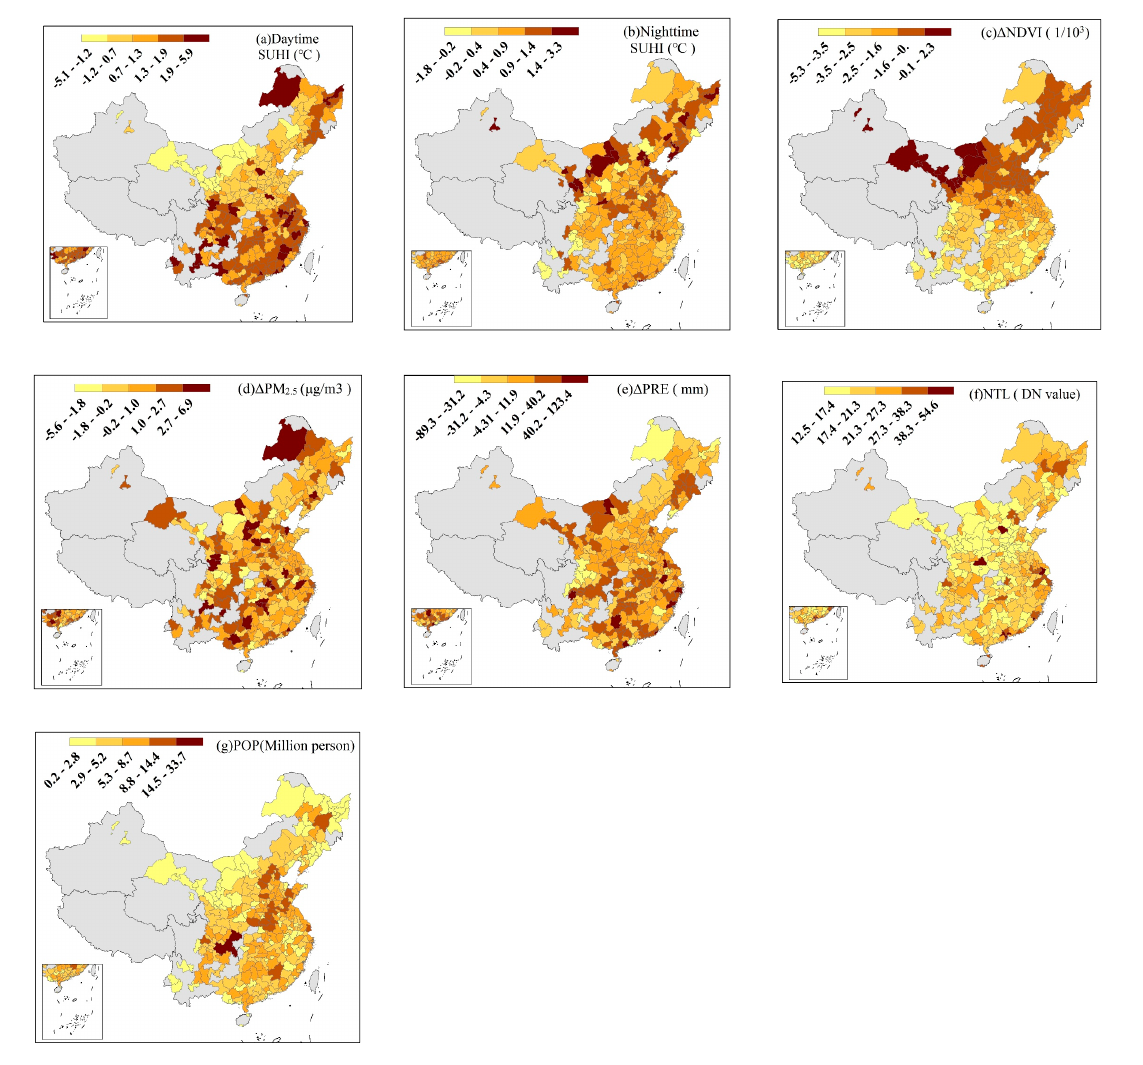
Figure 2. Spatial distributions of the variables used in the present study (using 2015 as an example). Note: SUHI = surface urban heat island intensity; ∆ NDVI = urban − rural differences of NDVI; ∆ PM 2.5 = urban − rural differences of fine particulate matter; ∆ Pre = urban − rural differences of precipitation; NTL = urban nighttime light; Pop = the population at the end of the year.